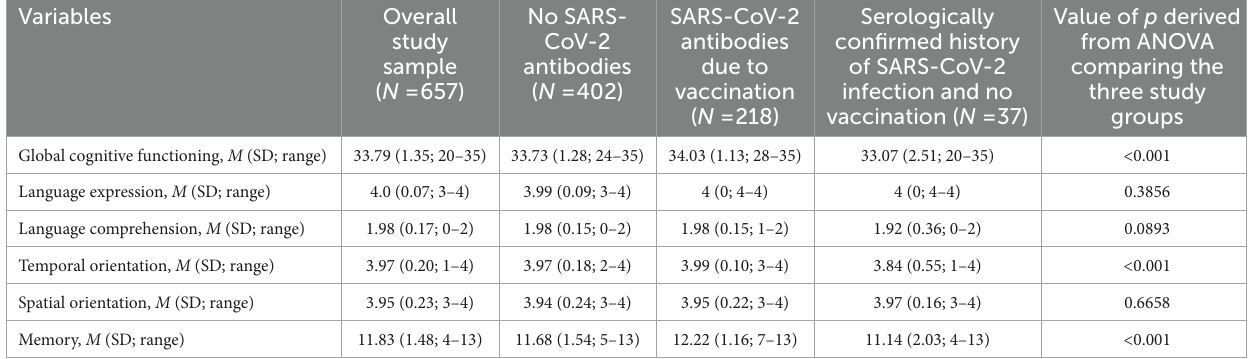
TABLE 2 Descriptive statistics for cognitive functioning for the overall study sample and across subgroups based on presence of COVID-19 antibodies. Variables